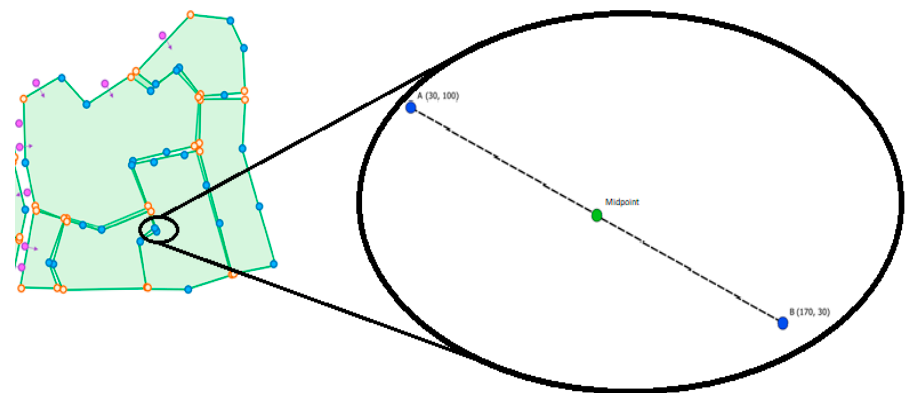
Figure 11. Symmetric point between points A and B.